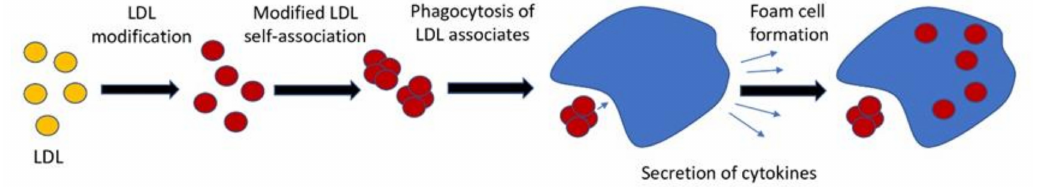
Figure 5. Role of inflammatory cytokines in triggering foam cell formation. Adapted from [37], with permission.